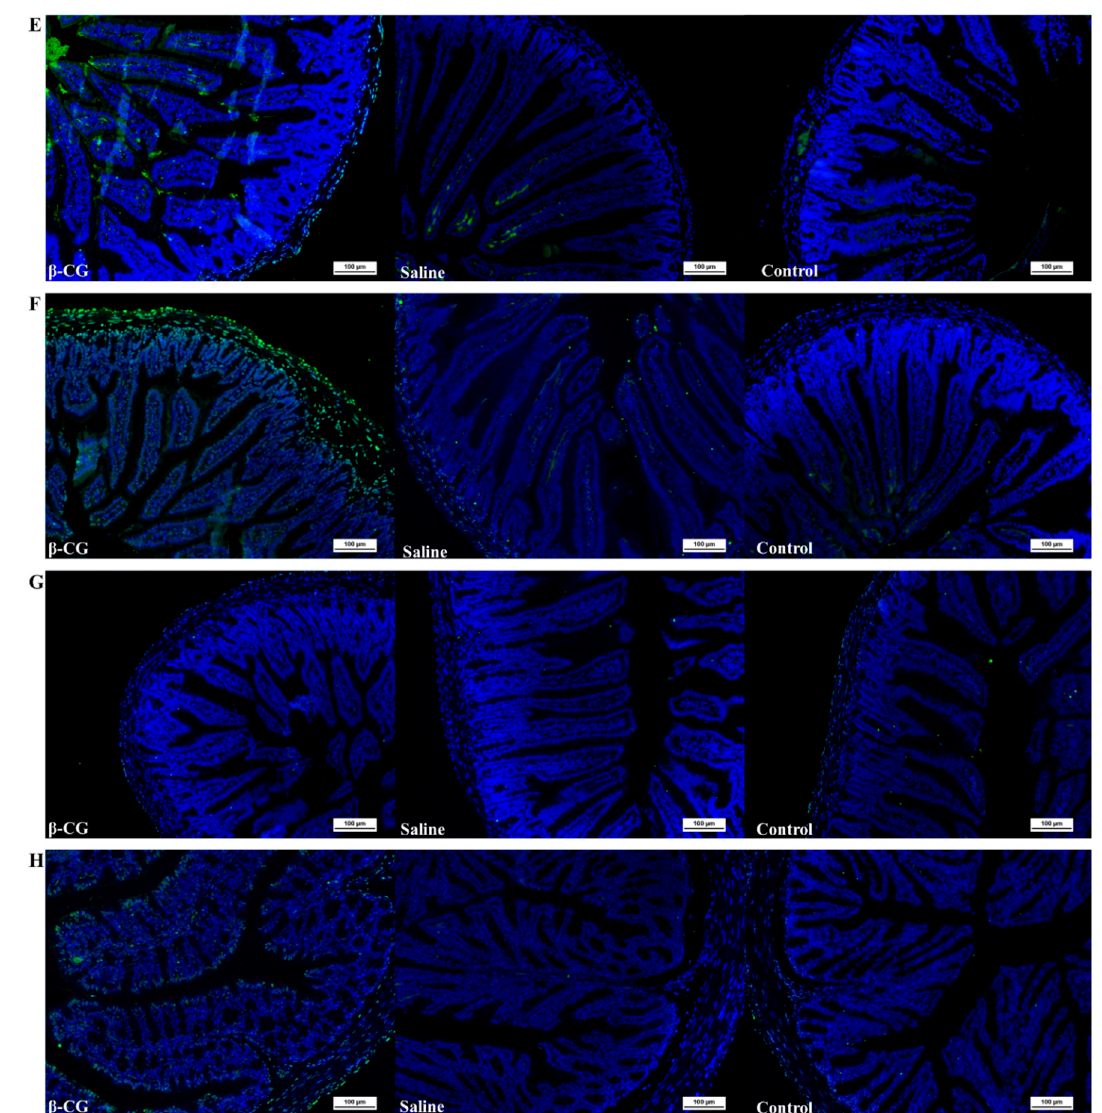
Figure 1. β -conglycinin ( β -CG) induced intestinal cell apoptosis in allergy mouse. ( A ) The score of anaphylaxis symptoms; ( B ) Levels of IgE; ( C ) Levels of histamine (HIS). ( D ) Terminal deoxynucleotidyl transferase-mediated dUTP nick-end labeling (TUNEL) assay on the number of apoptotic cells in duodenal, jejunum, ileum, colon. TUNEL assay on the pathological status in ( E ) duodenal; ( F ) jejunum; ( G ) ileum; ( H ) colon. (* p < 0.05; ** p < 0.01; *** p < 0.001).